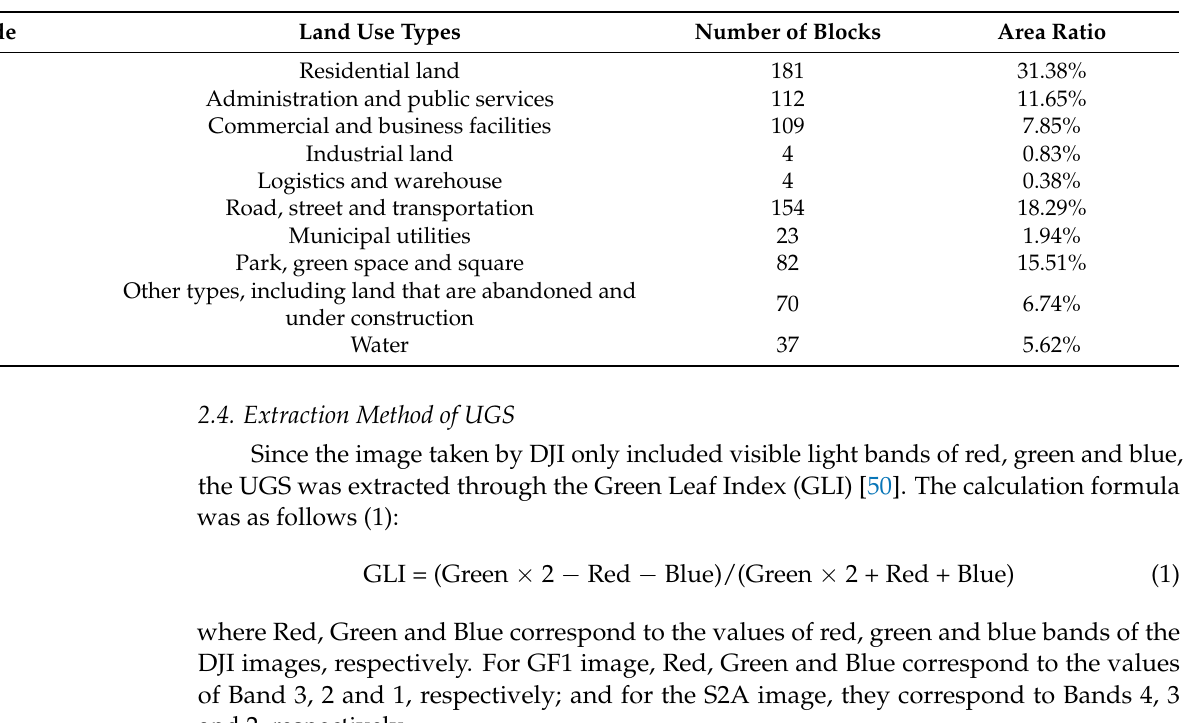
Table 2. The land use types of the study